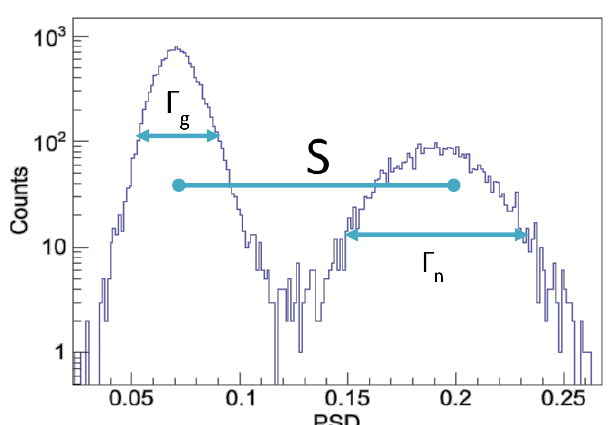
Fig.4. Typical example of FoM plot obtained by the projection of the PSD plot on the x axis. FWHMs and separation between centroids are shown in the plot. Centroids and FWHM are obtained by Gaussian fit of the plot. The fit is not shown